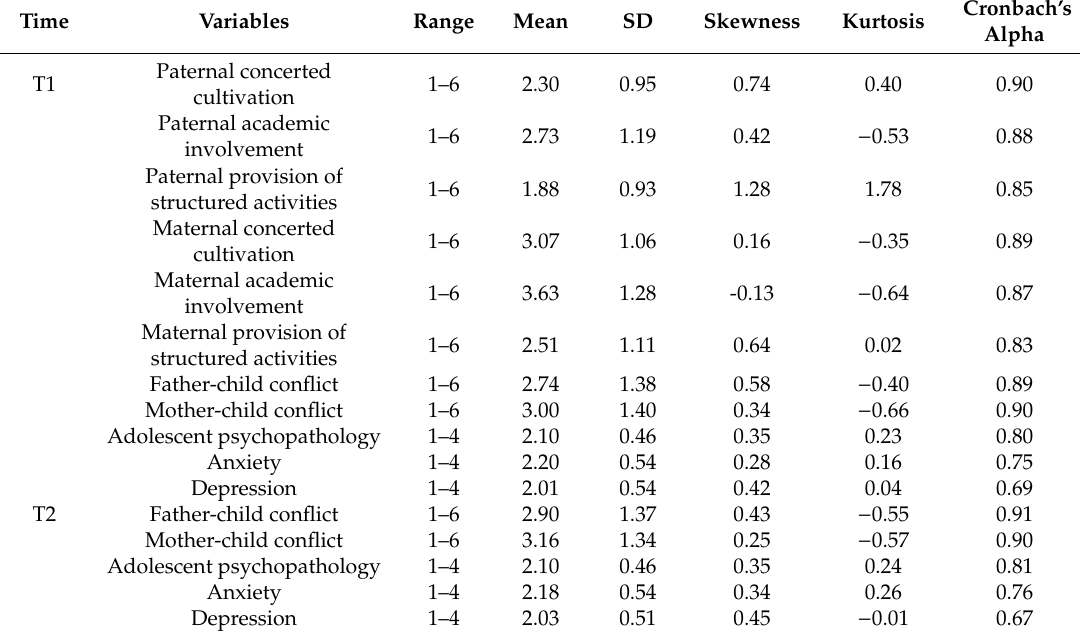
Table 1. Descriptive